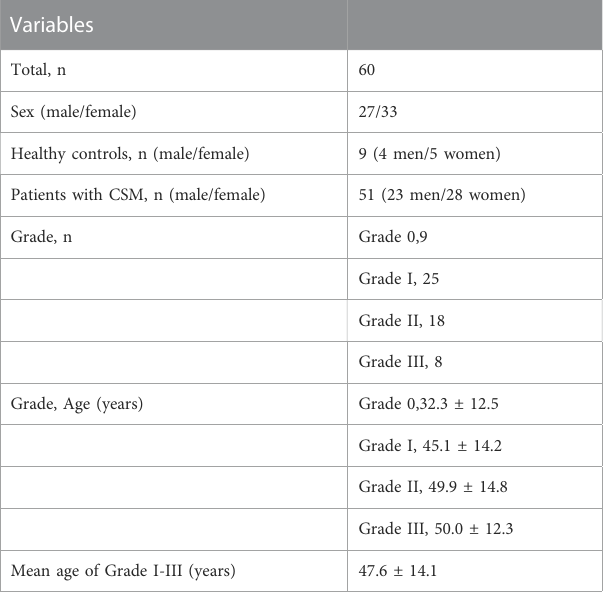
TABLE 1 Demographics of healthy controls and patients with cervical spondylotic myelopathy (CSM). Variables